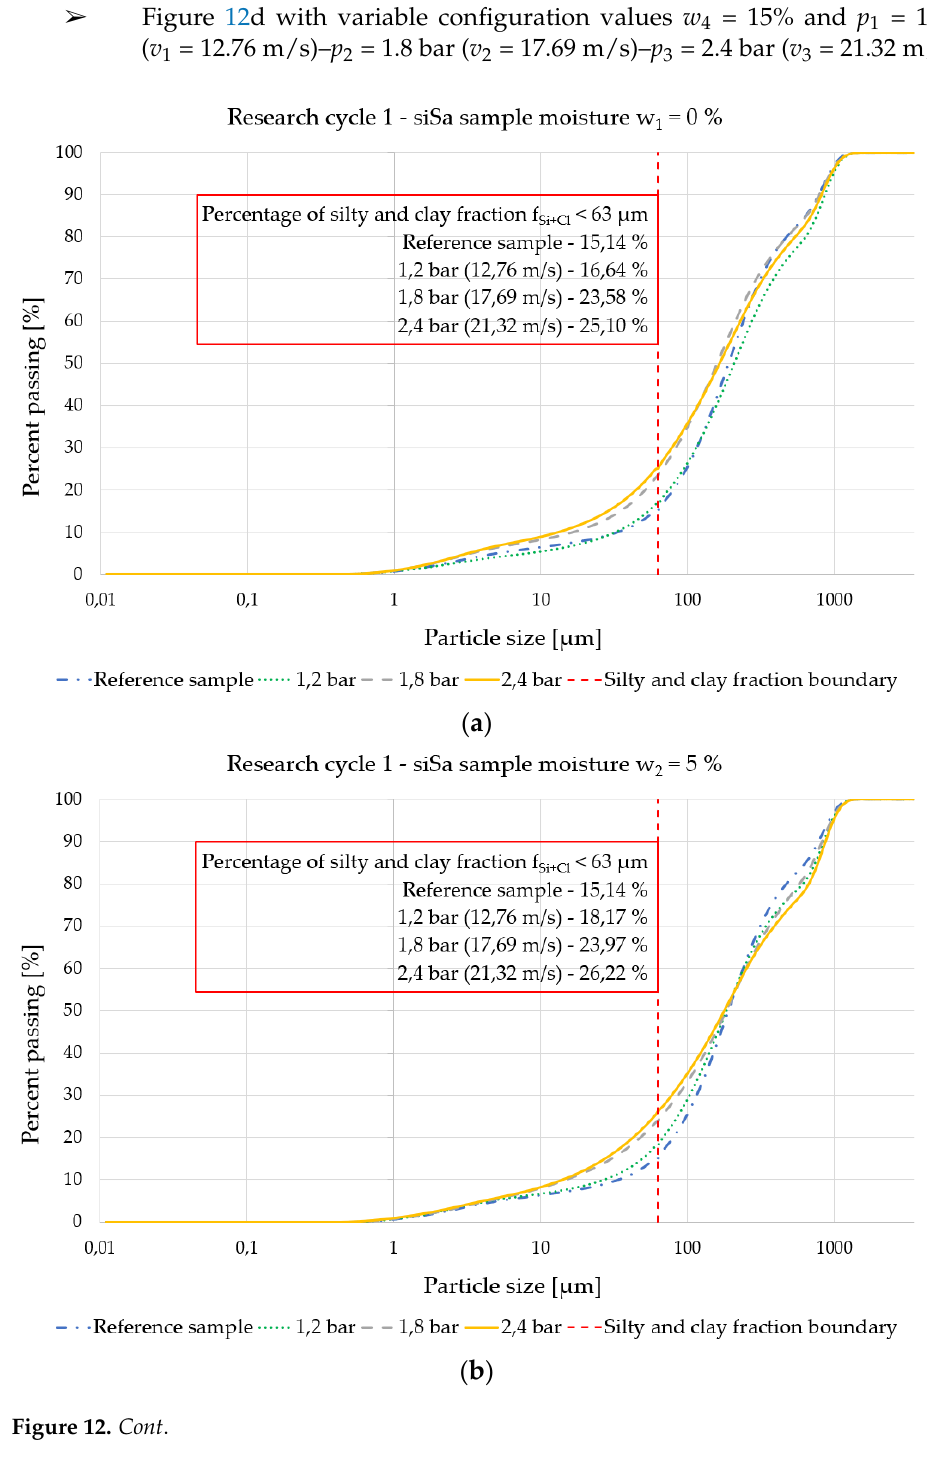
Figure 12b with variable configuration values w 2 = 5% and p 1 = 1.2 bar ( v 1 = 12.76 m/s)– p 2 = 1.8 bar ( v 2 = 17.69 m/s)– p 3 = 2.4 bar ( v 3 = 21.32 m/s); (cid:226) Figure 12c with variable configuration values w 3 = 10% and p 1 = 1.2 bar ( v 1 = 12.76 m/s)– p 2 = 1.8 bar ( v 2 = 17.69 m/s)– p 3 = 2.4 bar ( v 3 = 21.32 m/s); (cid:226) Figure 12d with variable configuration values w 4 = 15% and p 1 = 1.2 bar ( v 1 = 12.76 m/s)– p 2 = 1.8 bar ( v 2 = 17.69 m/s)– p 3 = 2.4 bar ( v 3 = 21.32 m/s);